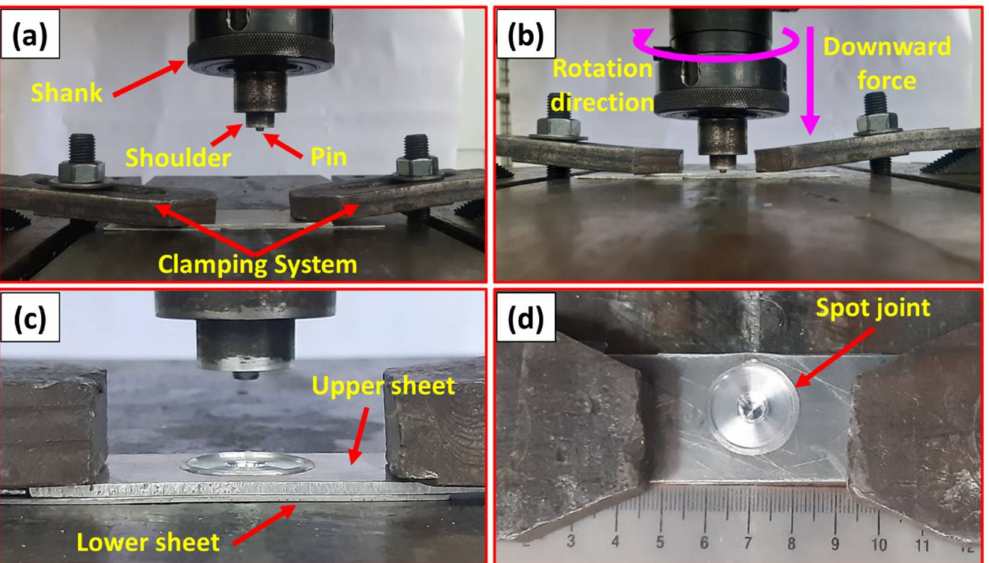
Figure 2. ( a – c ) illustrates the steps of the FSSW process of AA6082-T6 lap joints, while ( d ) shows the top view of the produced spot